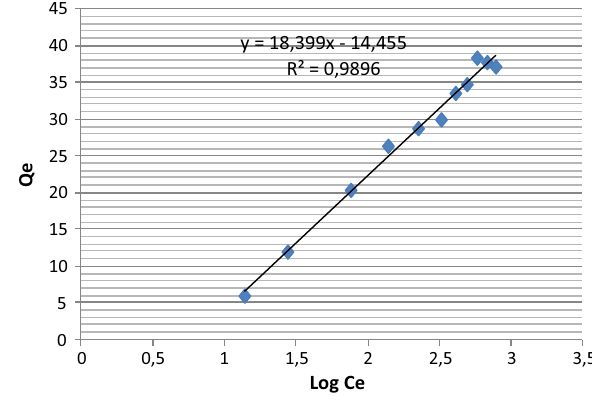
Fig. 4 Temkin adsorption